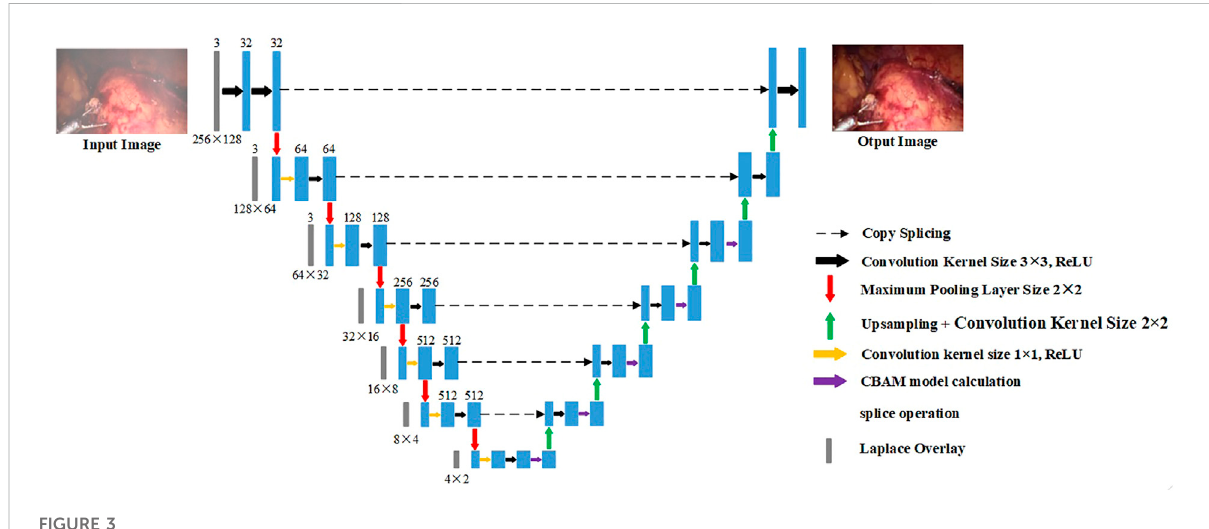
FIGURE 3 Encoder – decoder